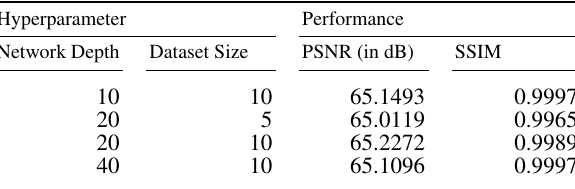
Table 2. Quantitative results of our application studies with varying network depth and dataset